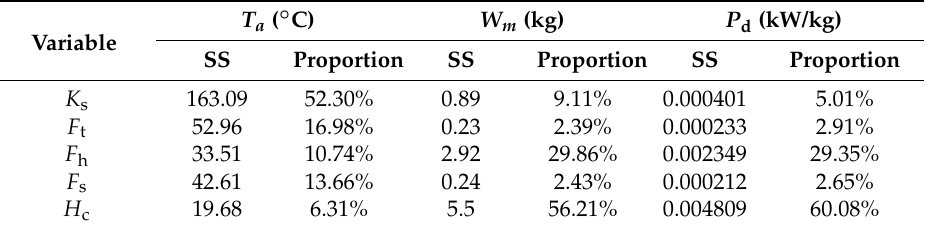
Table 11. Proportion of influences produced by various factors on motor